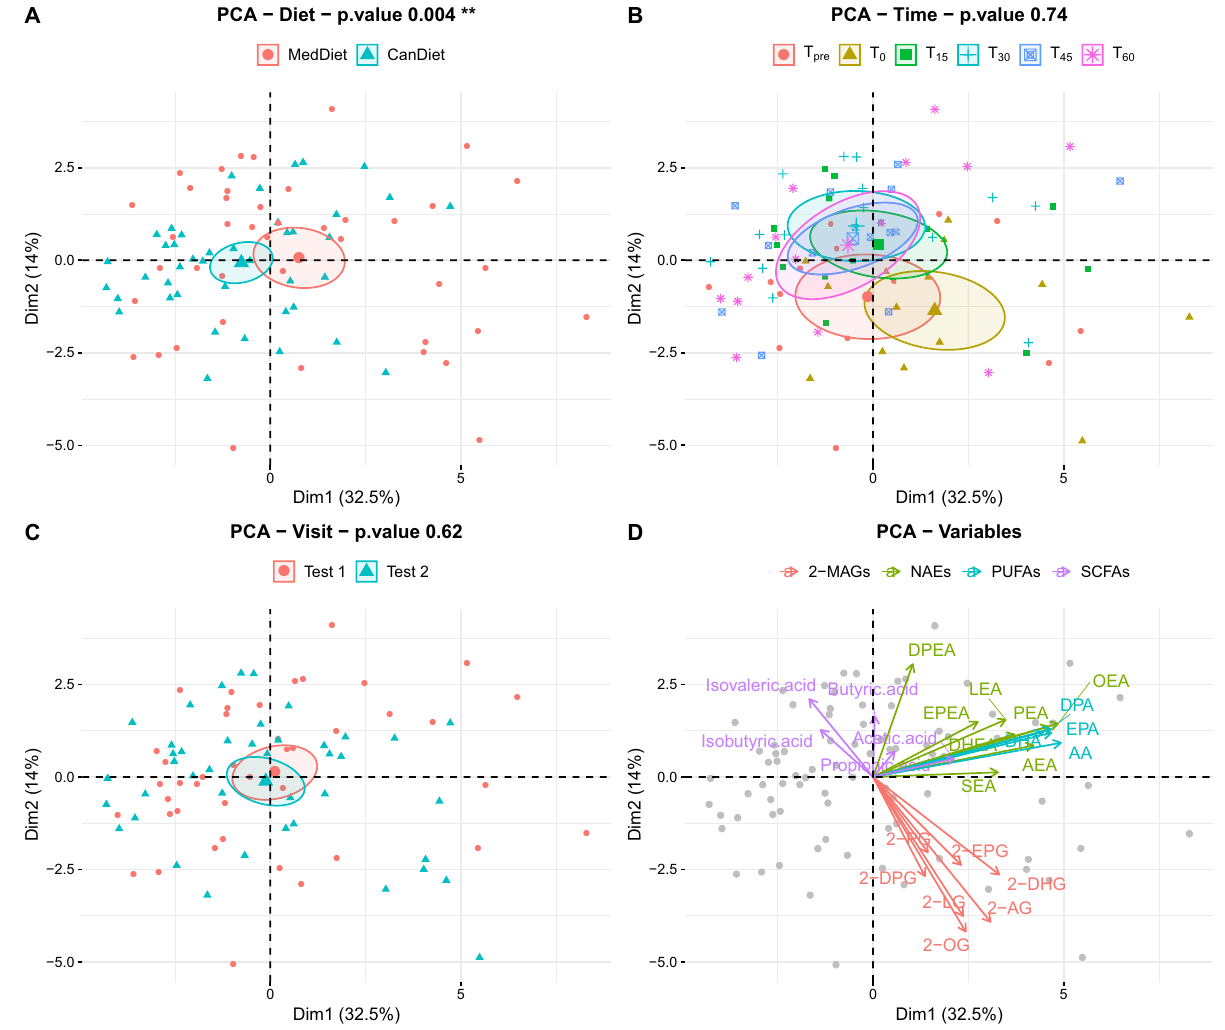
Figure 4. Representation of plasmatic lipid mediators and SCFA profiles shows an effect of diet and time post-exercise on the endocannabinoidome. Principal component analysis (PCA) of plasmatic profiles of free n-3 PUFA, endocannabinoids and endocannabinoid-like mediators and SCFA, where ellipses show how these metabolites differentiate ( A ) diet, ( B ) time points and ( C ) visits. ( D ) Loading plot shows the influence of plasmatic lipids on the PCA plot. P-values on PCA were obtained by permutational multivariate analysis of variance